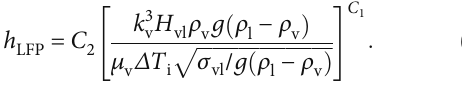
− ρ Þ  0 : 25 for cross-sections in Class l v